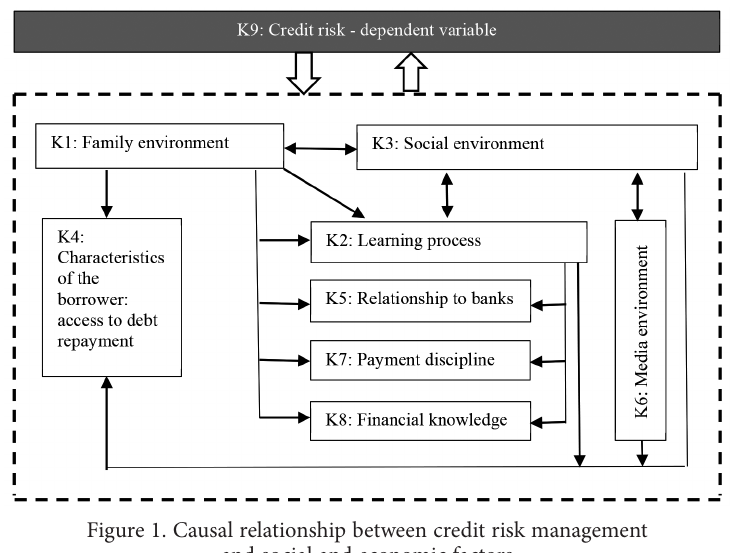
Figure 1. Causal relationship between credit risk management and social and economic factors (source: Own